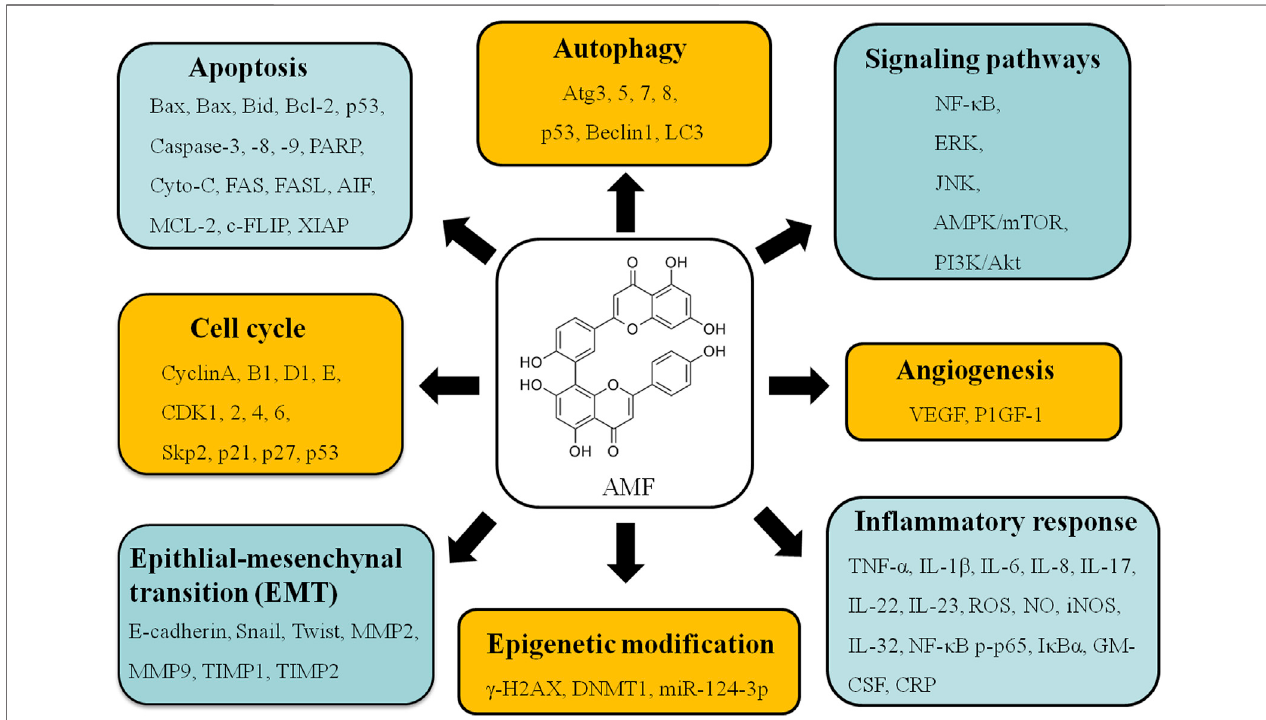
FIGURE 3 | Various molecular targets and signaling regulation modulated by AMF